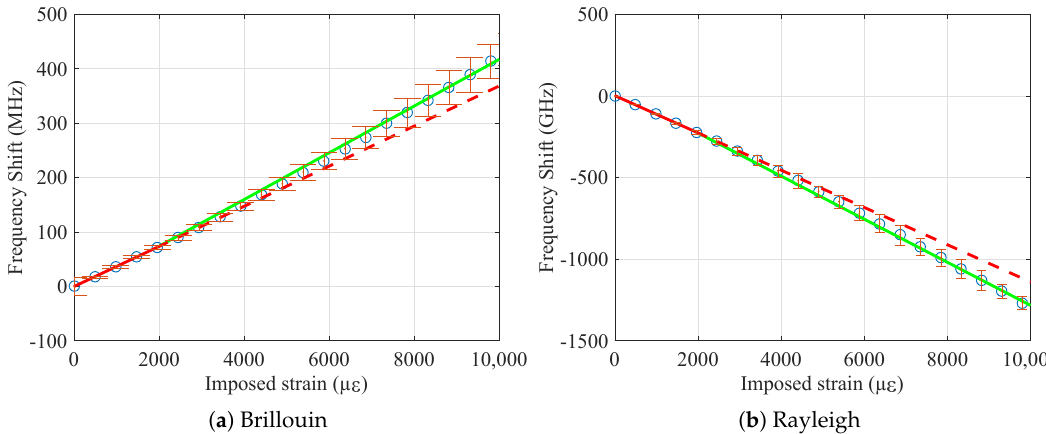
Figure 6. Detail of the mechanical behavior of the FIMT standard type sample (Sample d). The curve presents two zones with different slopes (highlighted in red and green): this represents the plasticity of the steel of which the FIMT is made.